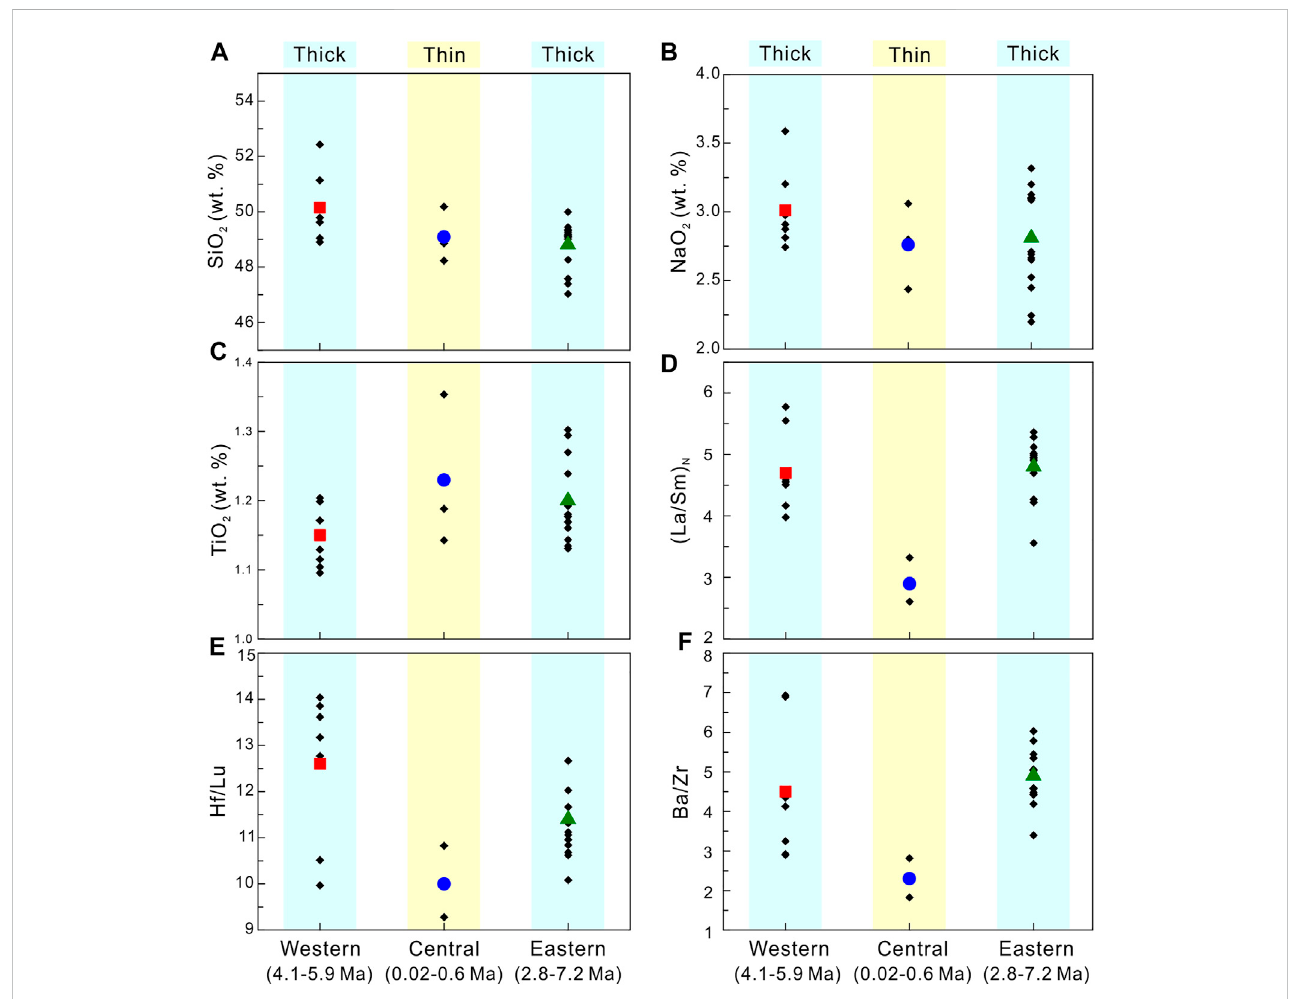
Covariance between lithospheric thickness and compositionof estimated primary magma. Black diamonds denote estimated primary composition. The red rectangle, blue circle and green triangle represent the average composition of samples from the west, middle and east, respectively. Light blue bands indicate thick lithosphere, and light yellow bands imply thin lithosphere. The ages are from previous studies (Mu et al., 1987; Guo et al., 2015; Zou et al., 2017; Cheng et al.,